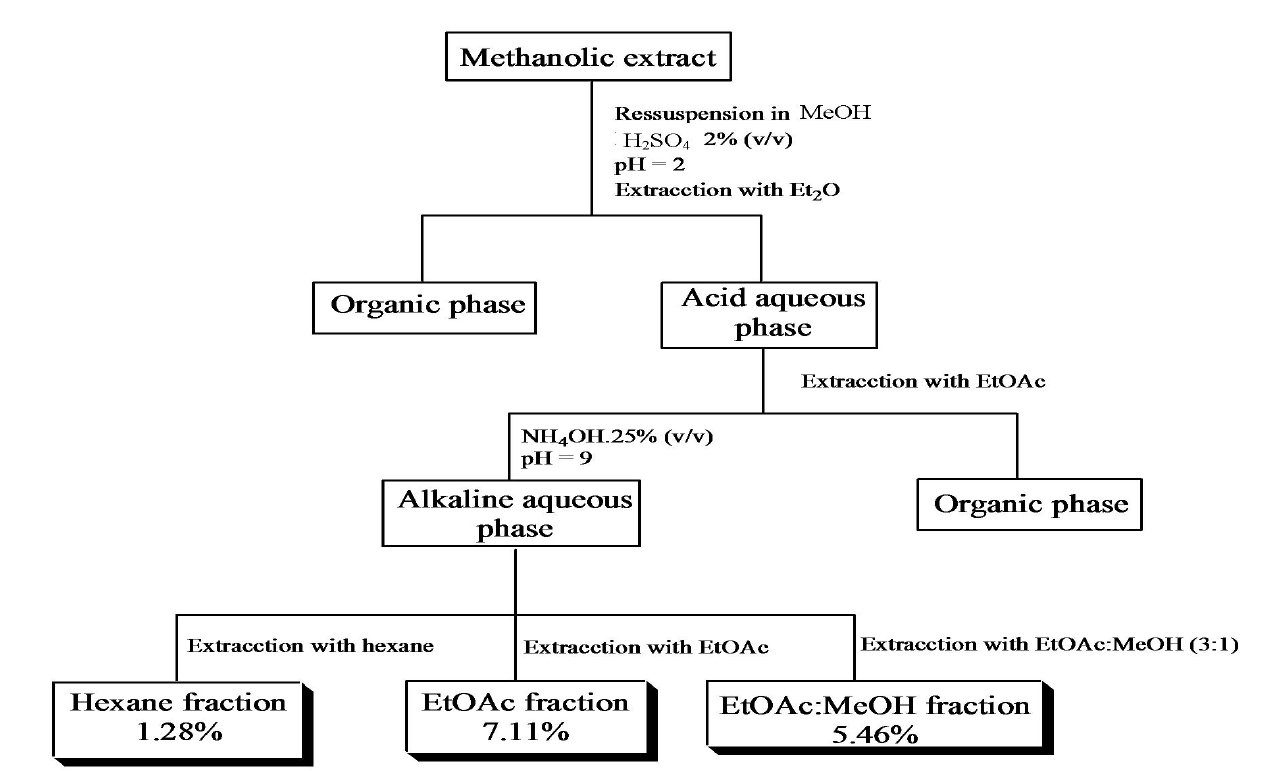
FIGURE 1 – Acid-base extraction process in the methanolic extract of the bulbsfrom Hippeastrum